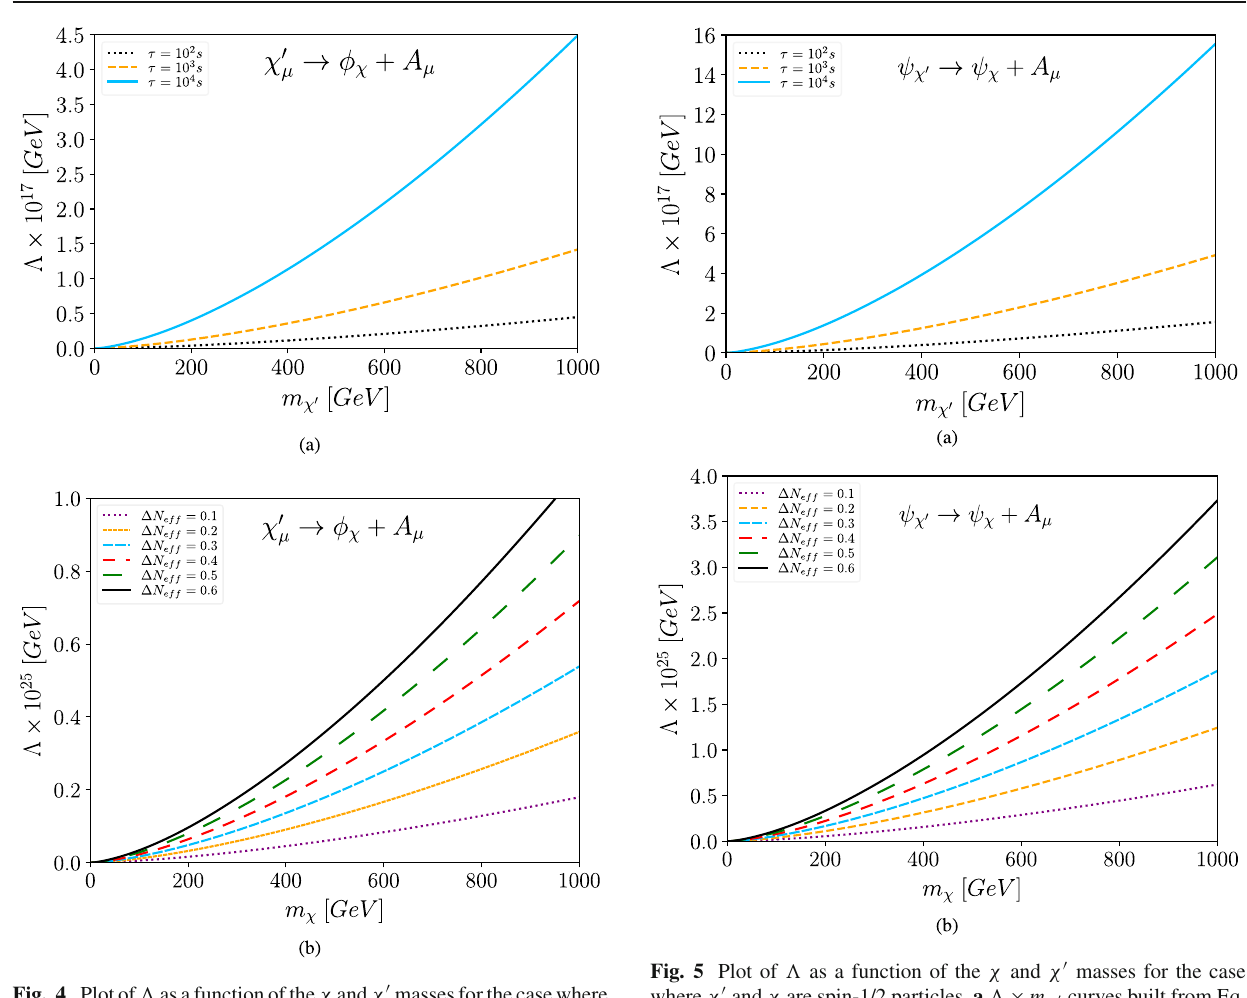
Fig. 4 Plotof (cid:2) asafunctionofthe χ and χ (cid:4) massesforthecasewhere χ (cid:4) is a spin-1, χ is a spin-0 particle. a (cid:2) × m χ (cid:4) curves built from Eq. (21), using τ = 10 2 , 10 3 and10 4 s. b (cid:2) × m χ curves constructed from